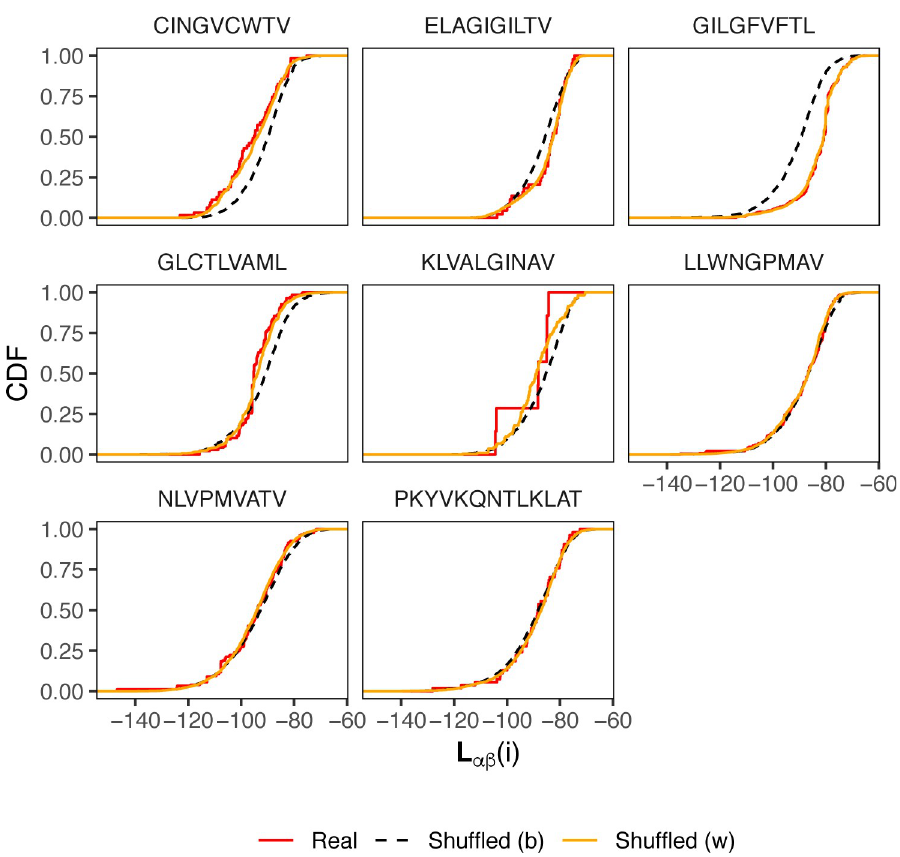
Fig 6. Log-likelihood (LL) distributions for TCR αβ pairs with known antigen specificity. Cumulative distribution functions of αβ pair LLs computed according to the model shown in Fig 4A . The plot shows n = 1388 real TCR αβ pairs from the VDJdb database (red curves), as well as pairs shuffled within groups specific to the same epitope (orange curves) and pairs shuffled across the entire dataset (dashed black curve). For the latter case, n = 10,000 pairs were selected at random for each epitope pair with re-sampling allowed in order to balance the dataset. Labels above panels are the cognate epitope sequences. Significant differences (Kolmogorov-Smirnov test P-value less than 0.05) between real and shuffled distributions are observed for CINGVCWTV (Kolmogorov-Smirnov test D-value = 0.25, P = 6x10 -4 ), ELAGIGILTV (D = 0.23, P = 2x10 -2 ), GILGFVFTL (D = 0.45, P < 10 − 15 ) and GLCTLVAML epitopes (D = 0.26, P = 3x10 -8